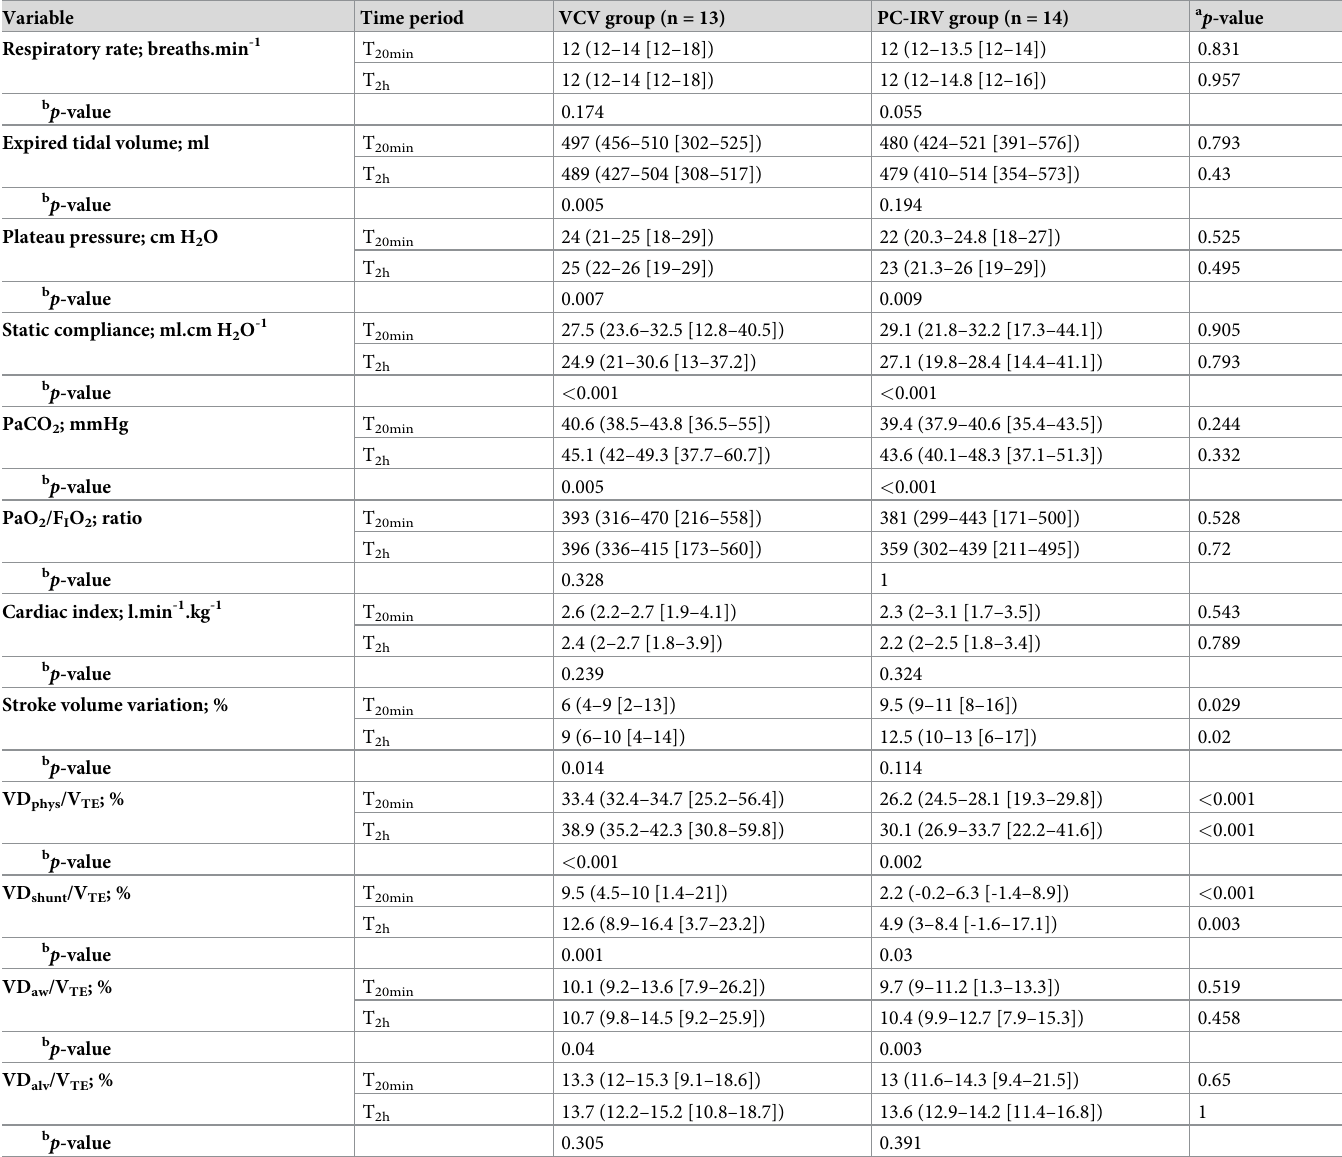
Table 3. Respiratory and hemodynamic parameters during